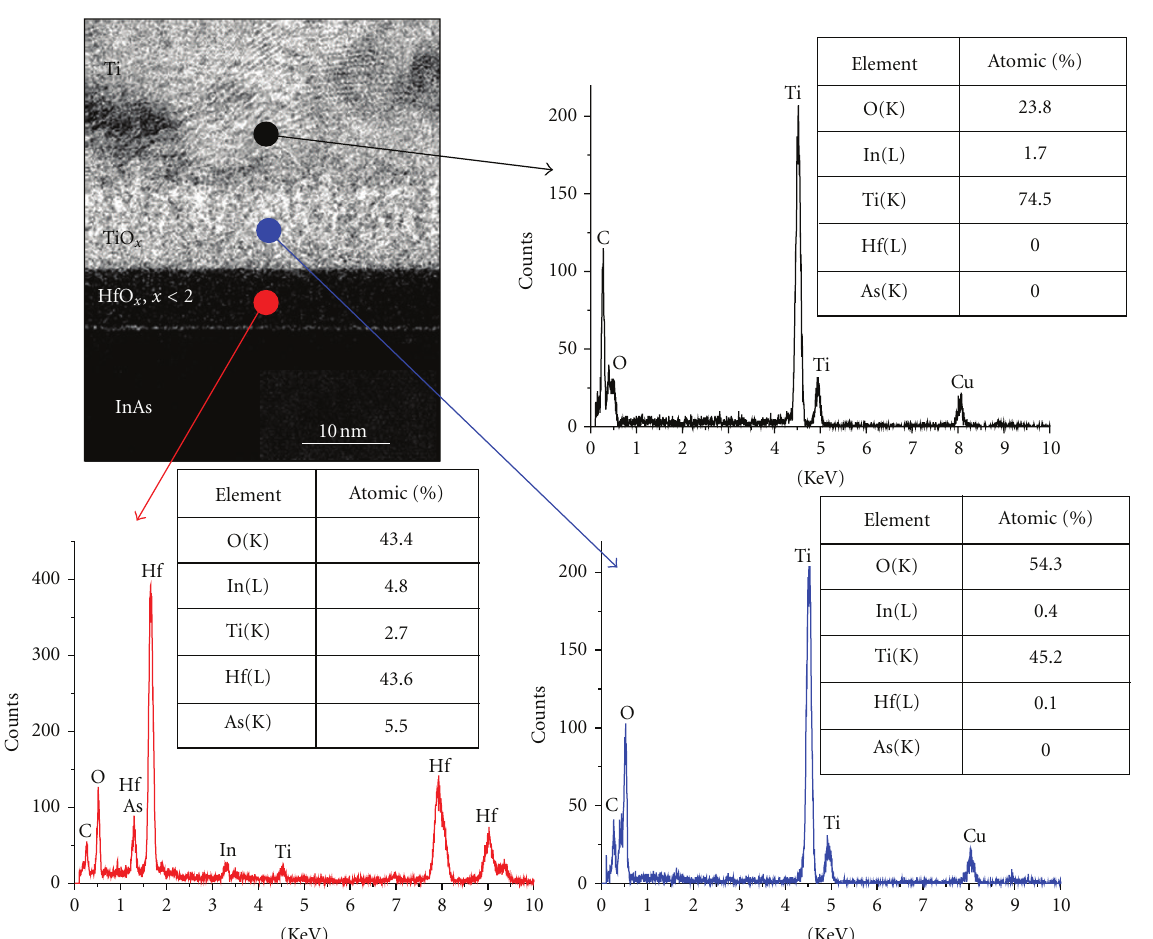
Figure 2: Energy dispersive X-ray spectroscopy (EDX) analysis obtained from various locations of Ti/InP/InAs MOS structure. EDX analysis reveals that an interfacial TiO x ( x ∼ 1.2) and Hf-rich oxide were formed after Ti deposition onto HfO 2 /InP/InAs